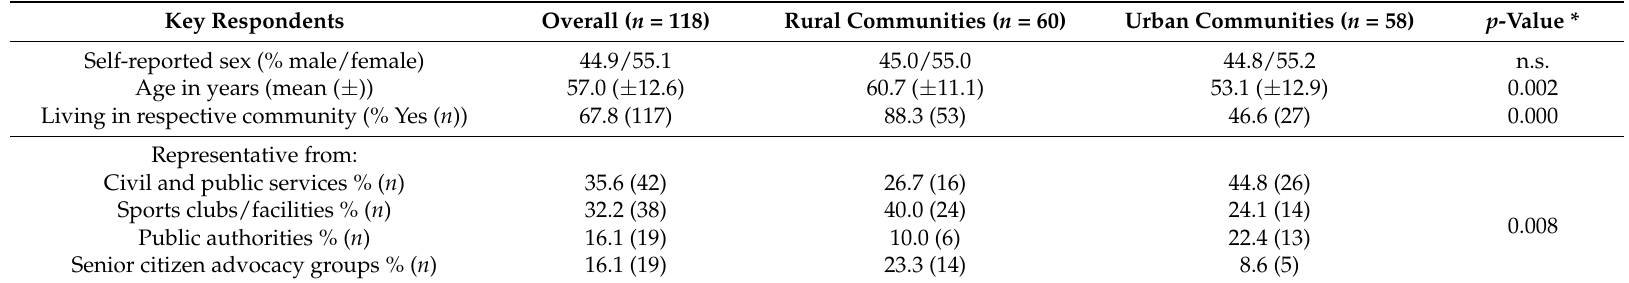
Table 2. Characteristics of the key